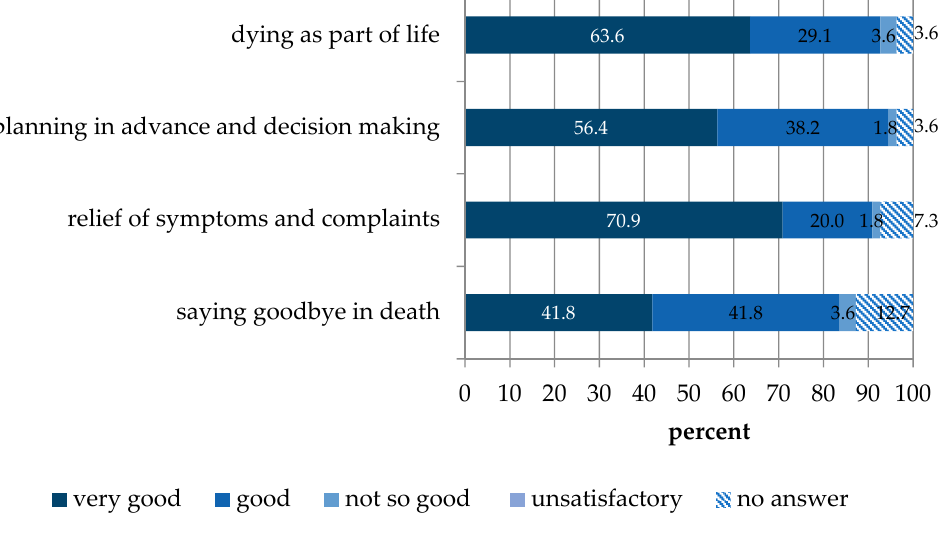
Figure 3. Evaluation of the Last Aid course modules (n = 55).